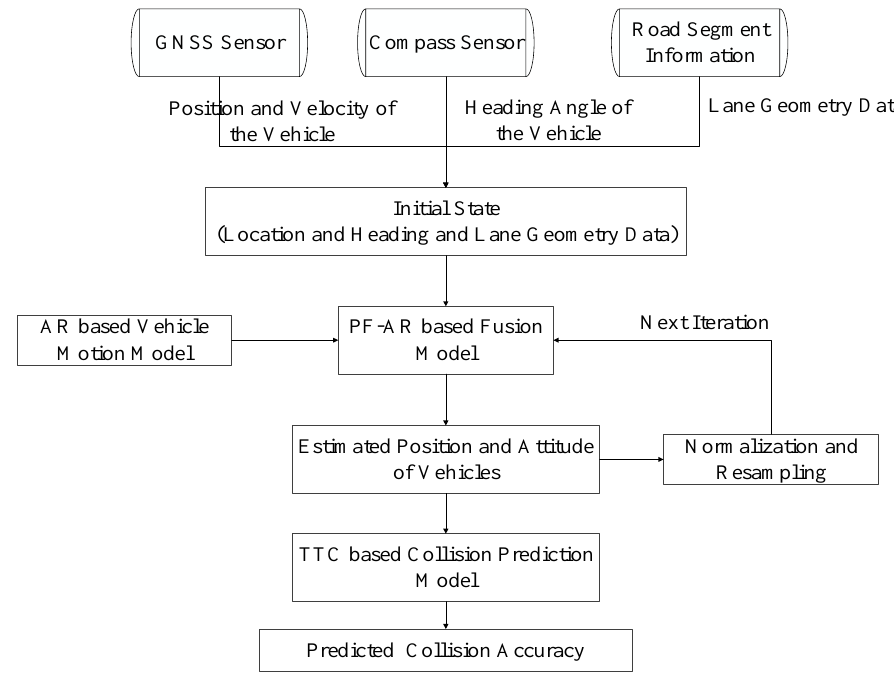
Figure 1. High level processes for the Global Navigation Satellite System (GNSS)/compass/road segment data fusion based vehicle-to-vehicle (V2V) collision avoidance system.